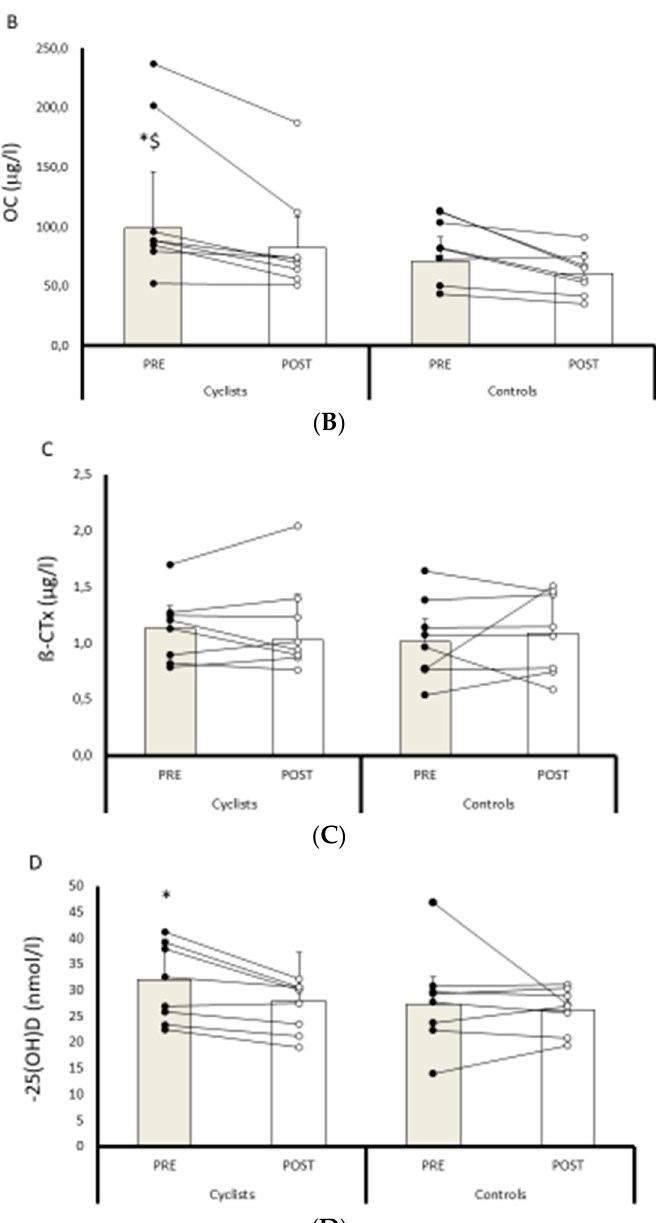
Figure 1. Panels ( A – D ) concentrations in cyclists ( n = 8) and controls ( n = 8), at pre- and post-evaluation. ( A ) Amino-terminal propeptide of type I precollagen (PINP). ( B ) Osteocalcin (OC). ( C ) beta-isomerized C-telopeptides ( β -CTx). ( D ) Plasma 25 hydroxyvitamin D [25(OH)D]. Values are presented as the mean and SD. For final statistical analysis one cyclist has been removed (statistical outlier). The p values calculated with one-way analysis of covariance (ANCOVA), adjusting for age. * p < 0.05 compared to control group. $ p < 0.05 compared to cyclists group.